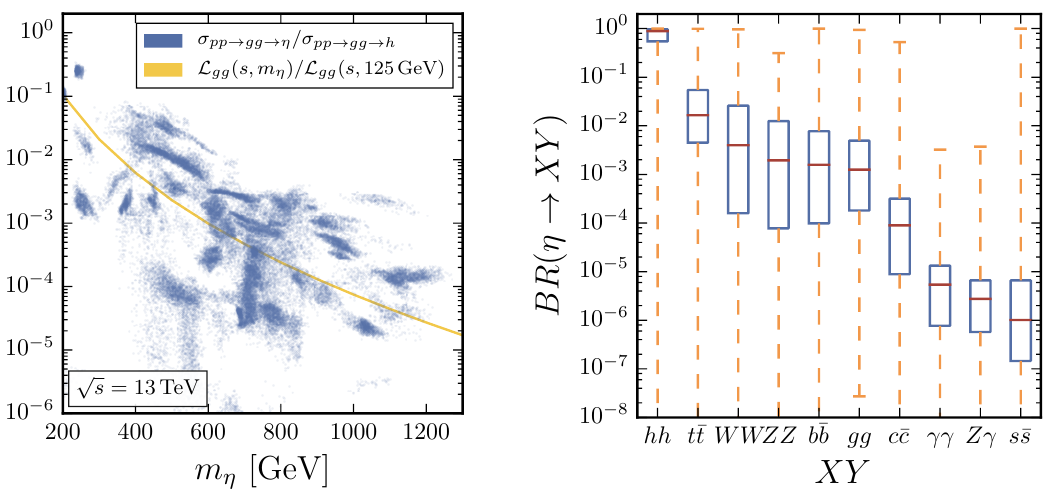
Figure 4 . Left: ratio of hadronic production cross sections via gluon fusion of (cid:17) and Higgs (blue dots) and ratio of gluon-gluon parton luminosities with p ^ s = m (cid:17) and p ^ s = 125 GeV. Right: box plot of the (cid:17) branching ratio for di(cid:11)erent decay channels. We did not include the usually very small up and down quark branching ratios. Like in the left plot of (cid:12)gure 3, we show the total and interquartile ranges and the median of values from viable parameter